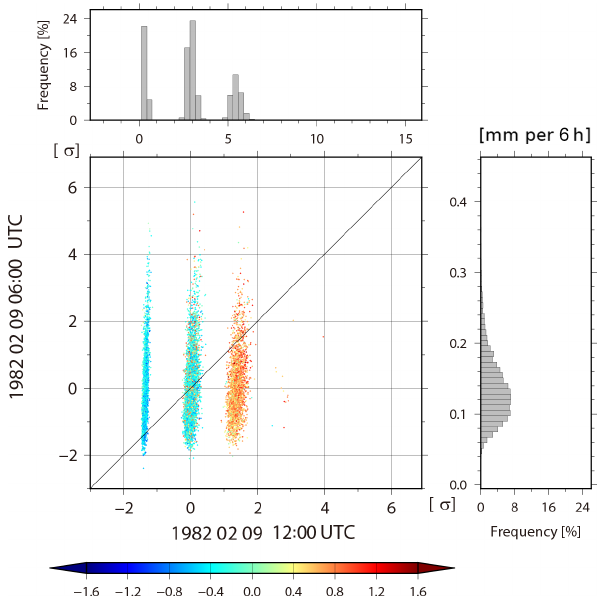
Figure 12. Similar to Fig. 11, but for 06:00UTC versus 12:00UTC on 9 February for background